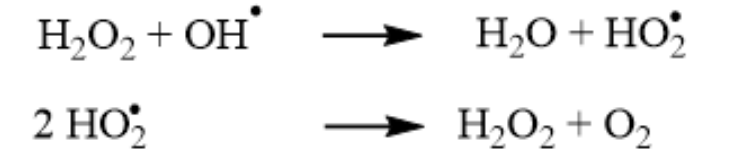
Figure 2. Radical formation from H 2 O 2 and OH • .